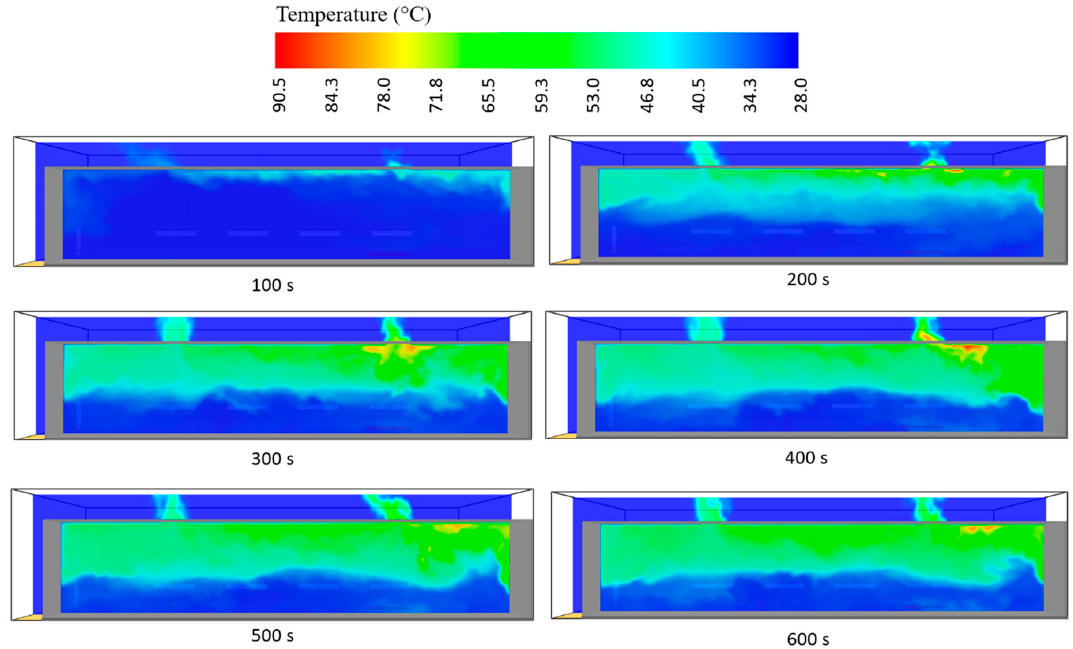
Figure 8. Temperature distribution in an xz plane that crosses two exhaust vents (y = 3.75 m) for di ff erent time periods (case 6).